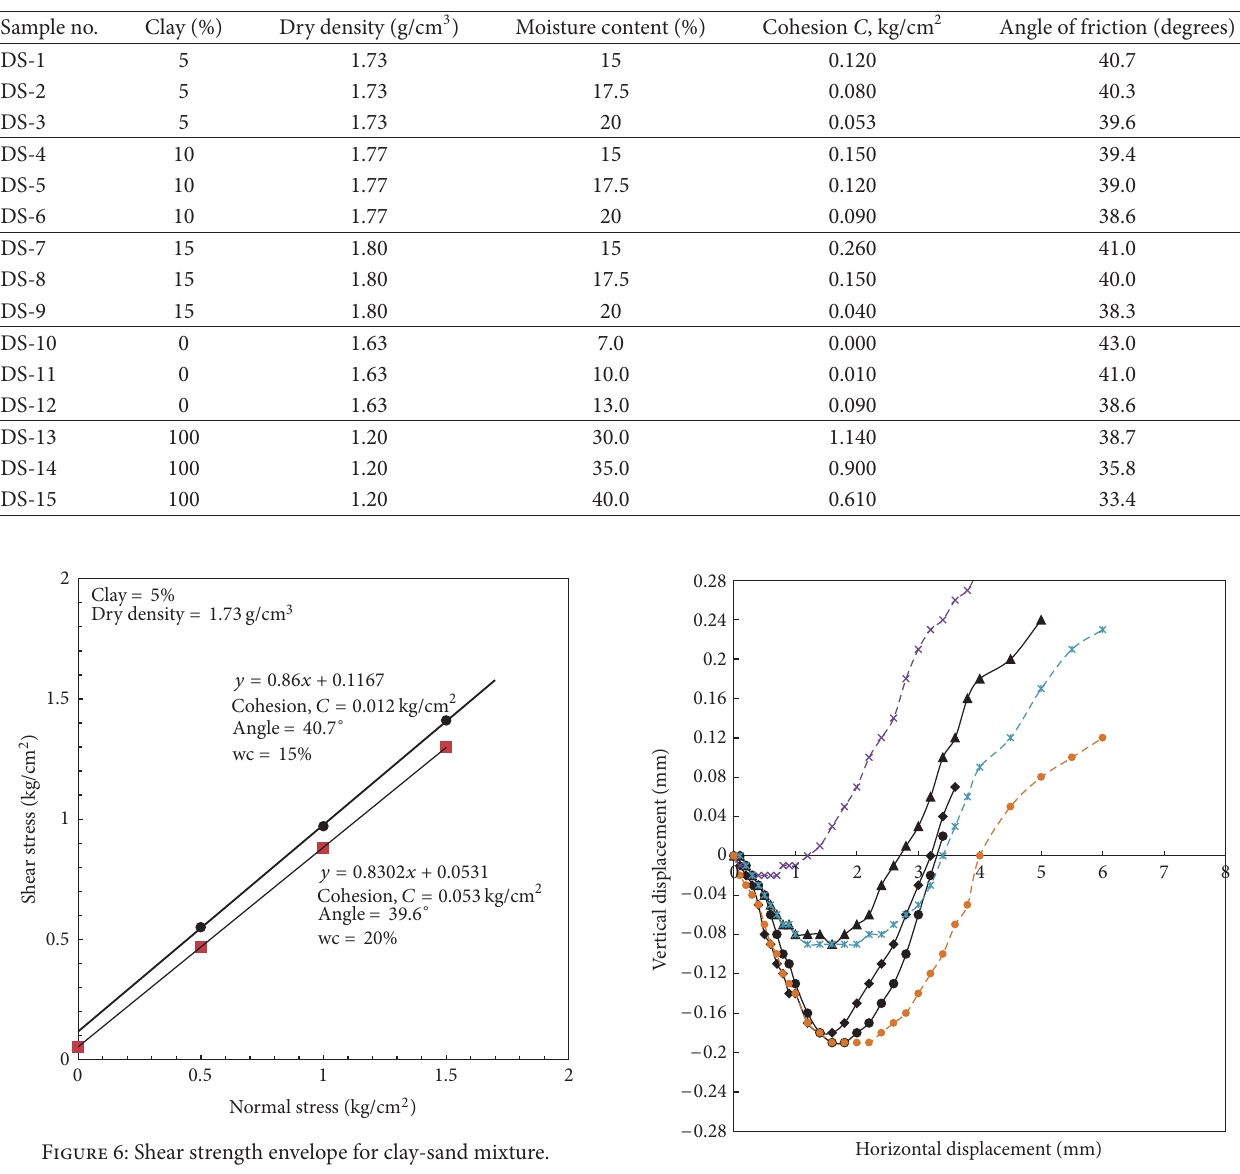
T 4: Direct shear test results.